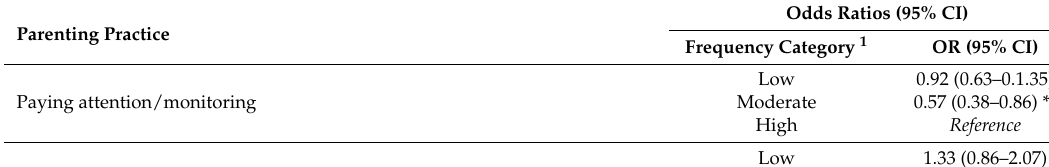
Table 3. Associations between parental practices on fruit juices and water consumption (high vs.